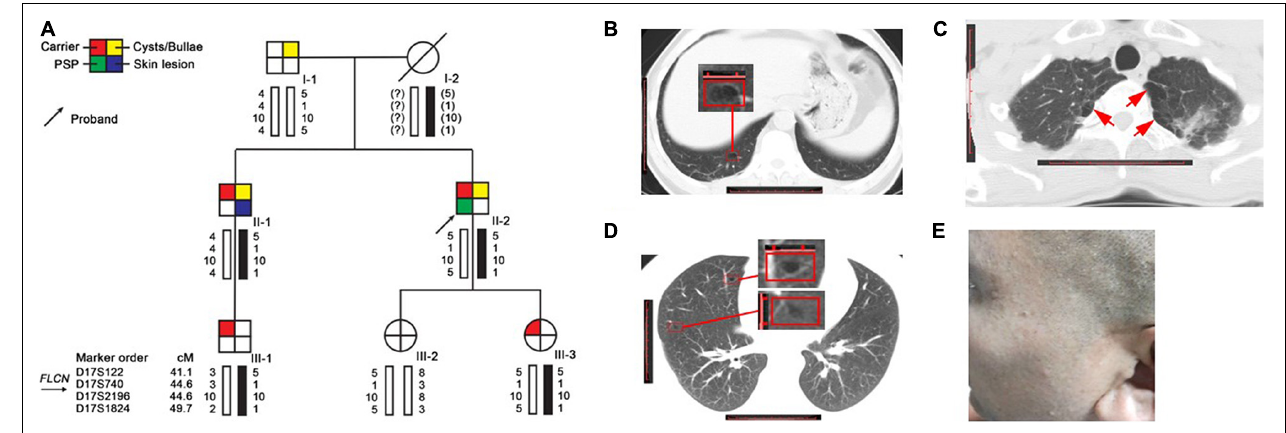
FIGURE 1 | Pedigree and clinical pictures of the family. (A) Pedigree and haplotype analysis. Numbers shown below each individual indicate the genotypes of the microsatellite markers in chromosomal order. The black bars represent the disease-associated haplotype. (B–D) Representative CT images of II-2 (B) , I-1 (C) , and II-1 (D) ; red frame: cyst; red arrow: bullae. (E) Several dome-shaped, skin-colored papules were seen on the face of II-1.